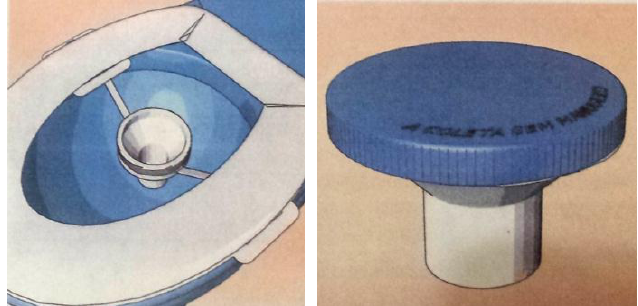
Figura 15. Pronto pra usar. Figura 16. pronto para ser levado ao